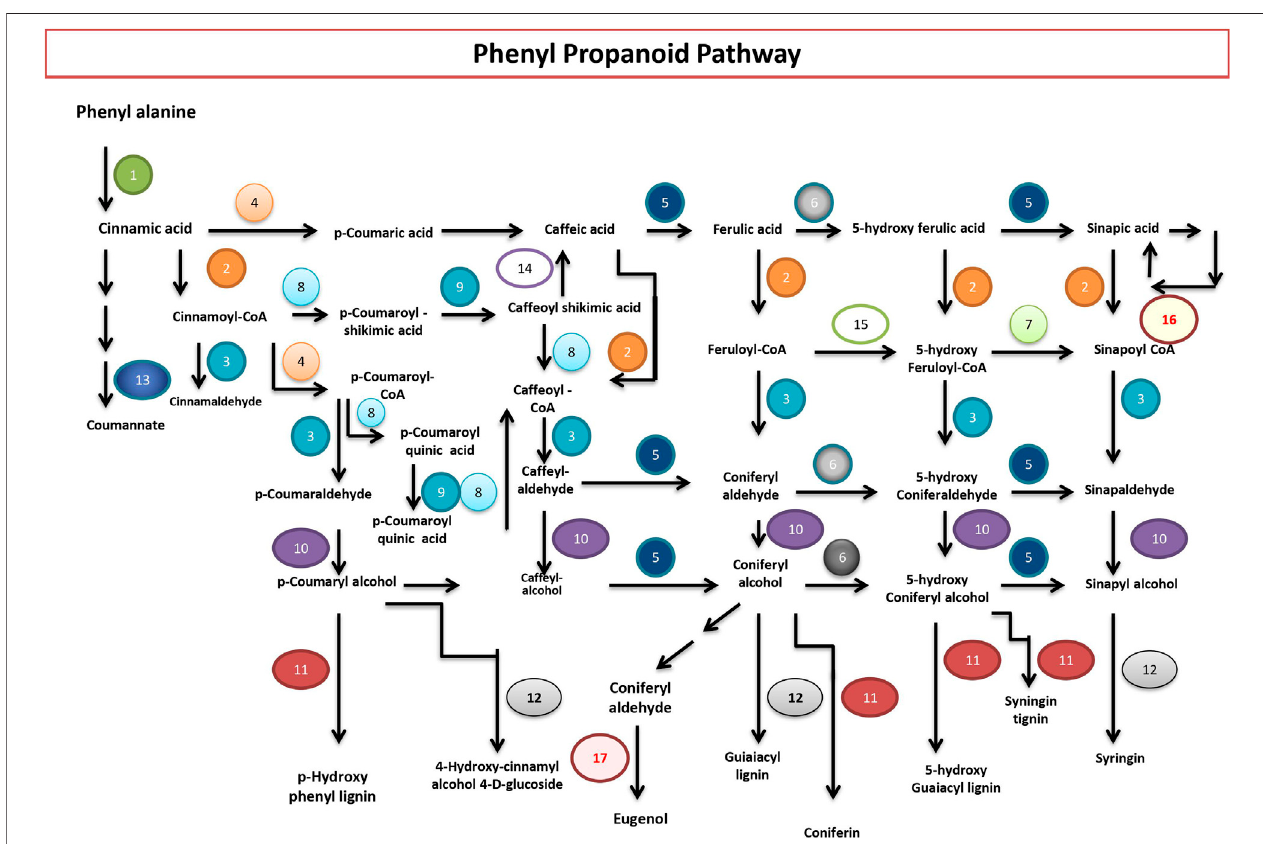
FIGURE 4 | Phenylpropanoid biosynthesis pathway in P. granatum . Numbers 1 to 17 represent the enzymes that catalyze the respective reactions. 1) PAL; phenylalanine ammonia-lyase [EC:4.3.1.24]; 2) 4CL; 4-coumarate--CoA ligase [EC:6.2.1.12]; 3) CCR; cinnamoyl-CoA reductase [EC:1.2.1.44]; 4) CYP73A; trans- cinnamate 4-monooxygenase [EC:1.14.13.11]; 5) E2.1.1.68; caffeic acid 3-O-methyltransferase [EC:2.1.1.68]; 6) CYP84A; ferulate-5-hydroxylase [EC:1.14.-.-]; 7) E2.1.1.104; caffeoyl-CoA O-methyltransferase [EC:2.1.1.104]; 8) E2.3.1.133; shikimate O-hydroxycinnamoyltransferase [EC:2.3.1.133]; 9) CYP98A; coumaroylquinate (coumaroylshikimate) 3 ′ -monooxygenase [EC:1.14.13.36]; 10) E1.1.1.195; cinnamyl-alcohol dehydrogenase [EC:1.1.1.195]; 11) E1.11.1.7; peroxidase [EC:1.11.1.7]; 12) UGT72E; coniferyl-alcohol glucosyltransferase [EC:2.4.1.111]; 13) bglB; beta-glucosidase [EC:3.2.1.21]; 14) CSE;